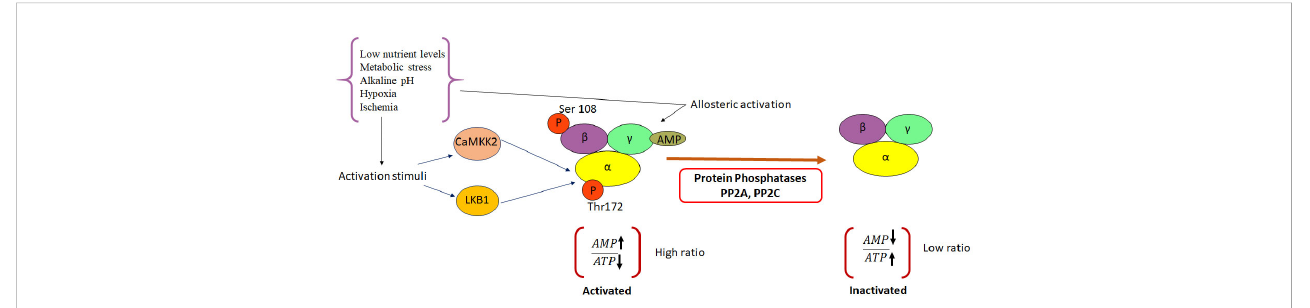
FIGURE 1 Molecular mechanisms leading to activation and inactivation of AMPK. AMPK is phosphorylated by the two upstream kinases, LKB1 and CAMKK b in response to various activation stimuli. Protein phosphatases PP2A and C cause de-phosphorylation of AMPK and render it inactive. CAMKK2, Ca 2 + /Calmodulin-dependent protein kinase kinase 2; LKB1, Liver kinase B1; AMP, Adenosine mono phosphate; PP2A, protein phosphatase 2; PP2C, protein phosphatase 2C; ATP-Adenosine